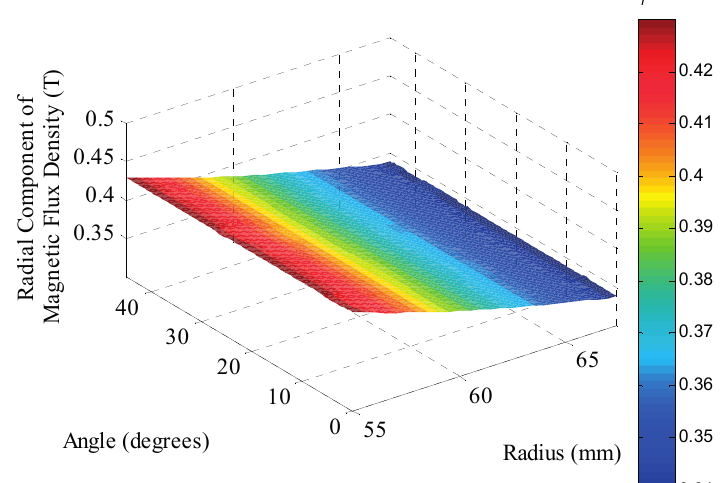
Figure 9. Radial component of magnetic flux density in the region of the coils at a section located at τ /2 of the actuator with ideal radial m